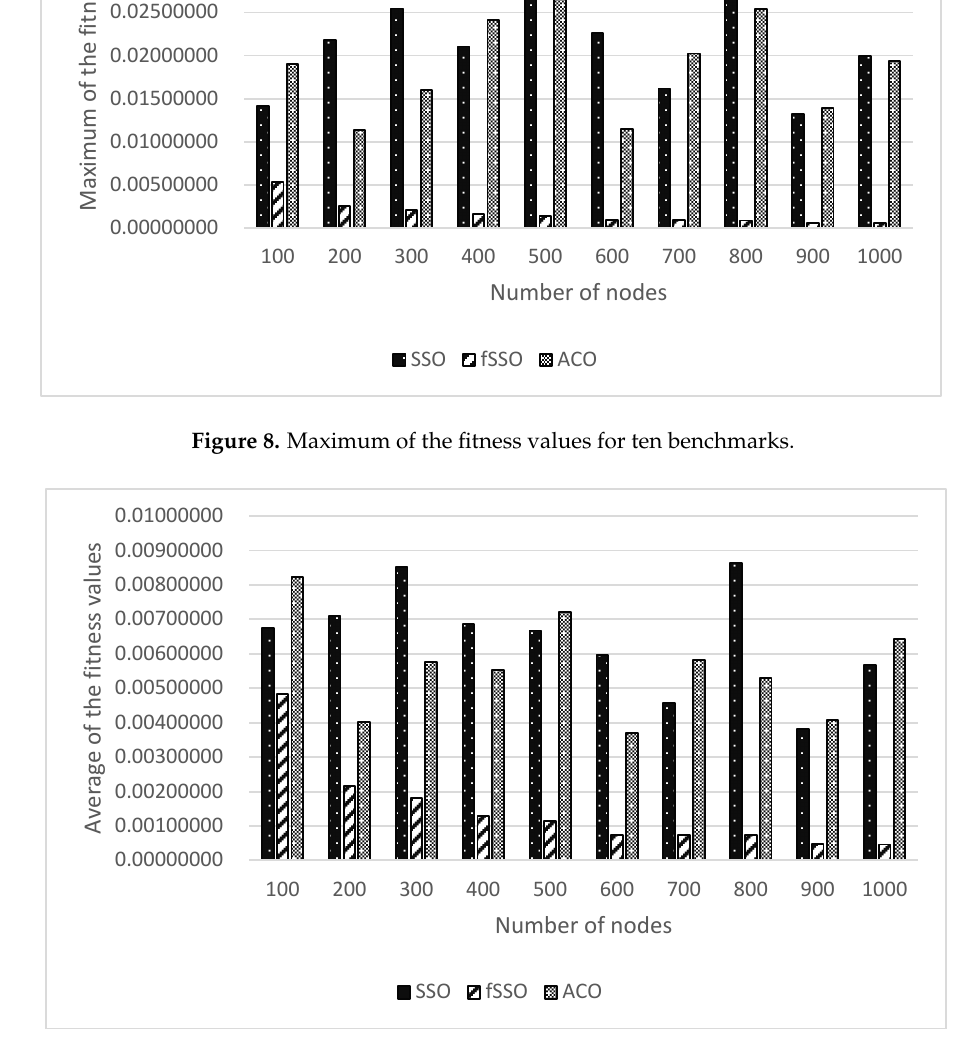
Figure 9. Average of the fitness values for ten benchmarks. Table 12. Minimum of fitness values of fSSO compared with SSO and Ant colony optimization (ACO) for ten